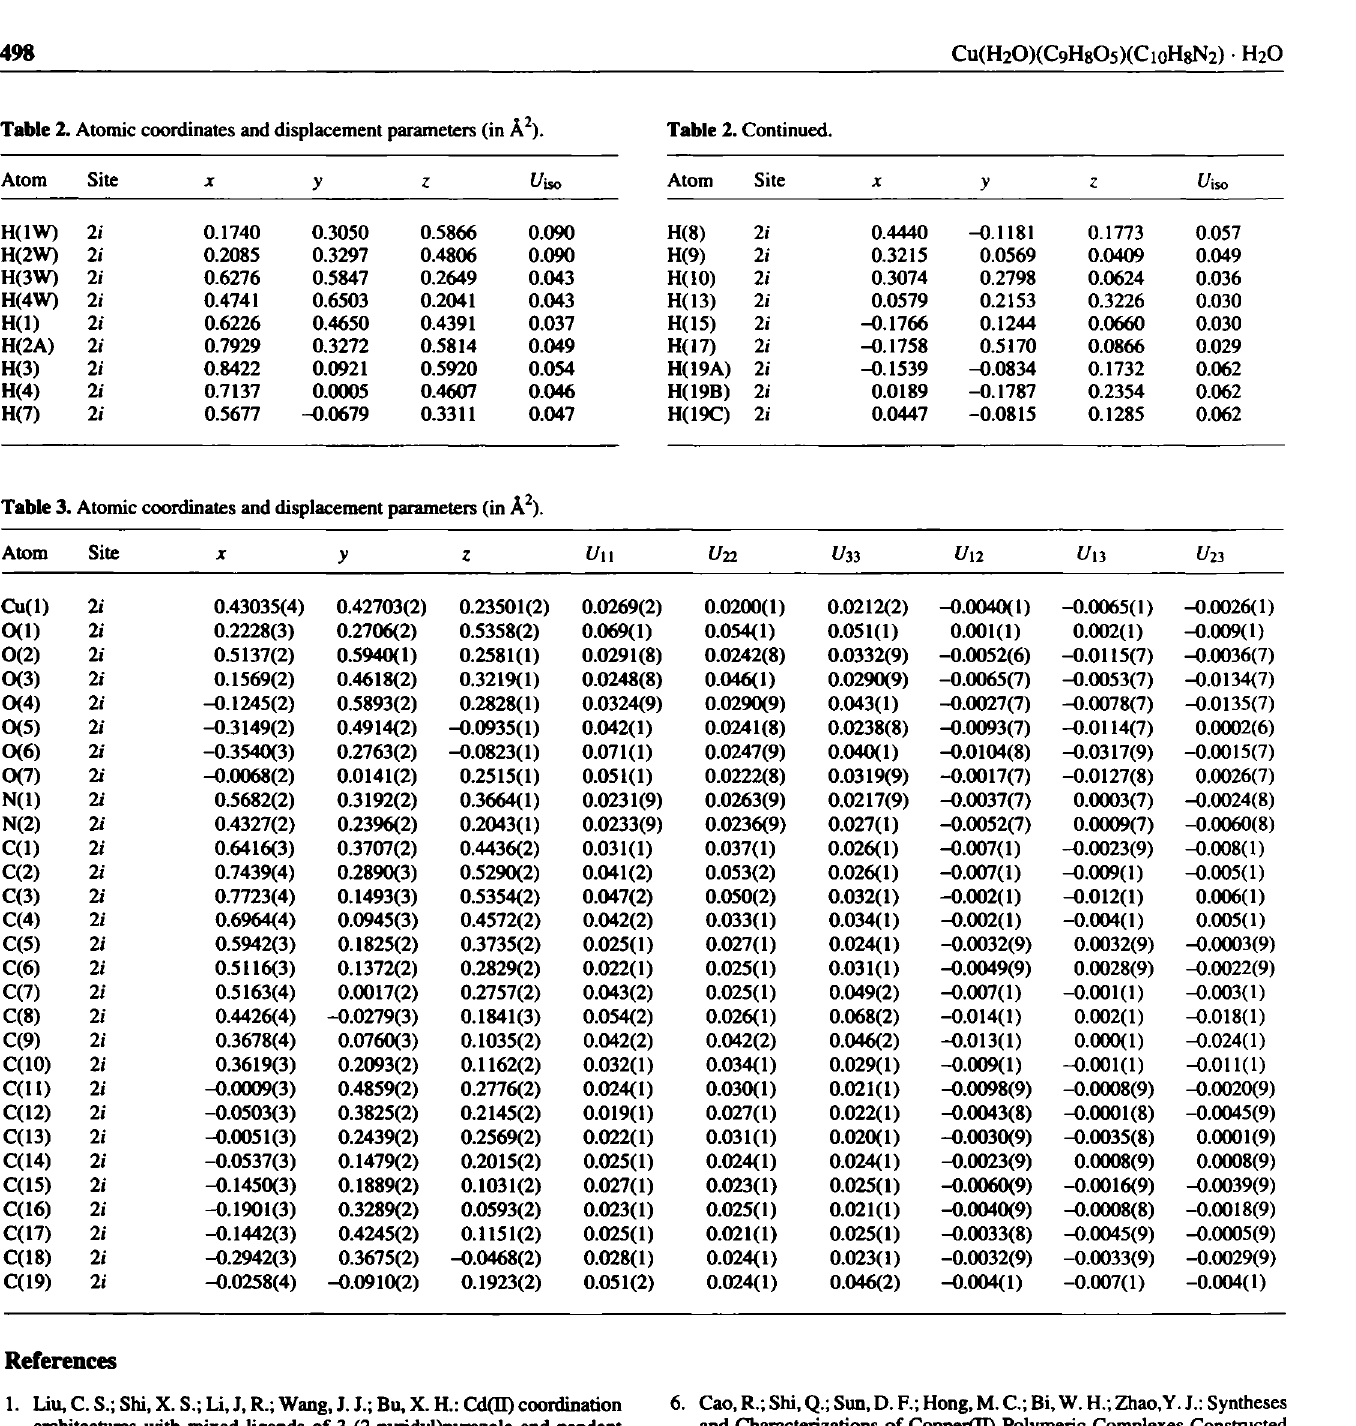
Table 2. Atomic coordinates and displacement parameters (in Â 2 ).